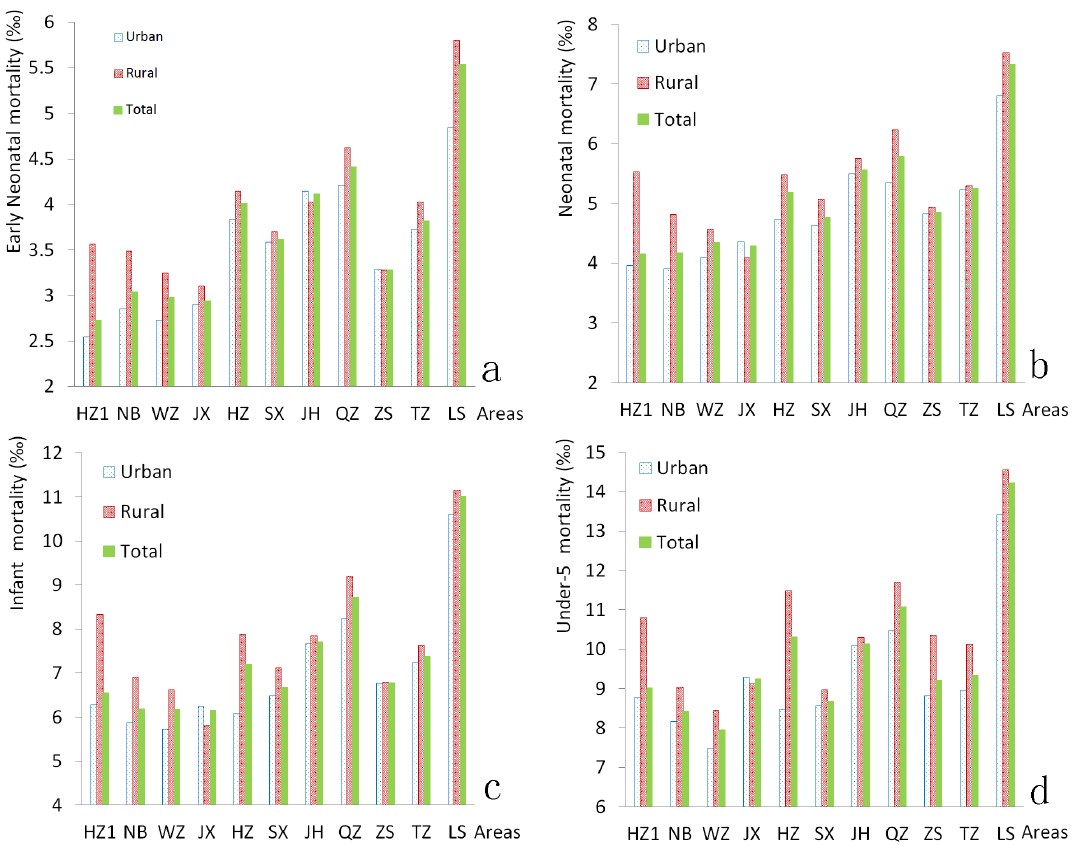
Figure 4. Mortality rates among the 11 administrative regions. (a) Early neonatal mortality; (b) Neonatal mortality; (c) Infant mortality; (d) Under-5 mortality. (HZ1, Hangzhou; NB, Ningbo; WZ, Wenzhou; JX, Jiaxing; HZ, Huzhou; SX, Shaoxing; JH, Jinhua; QZ, Quzhou; ZS, Zhoushan; TZ, Taizhou; LS, Lisui).